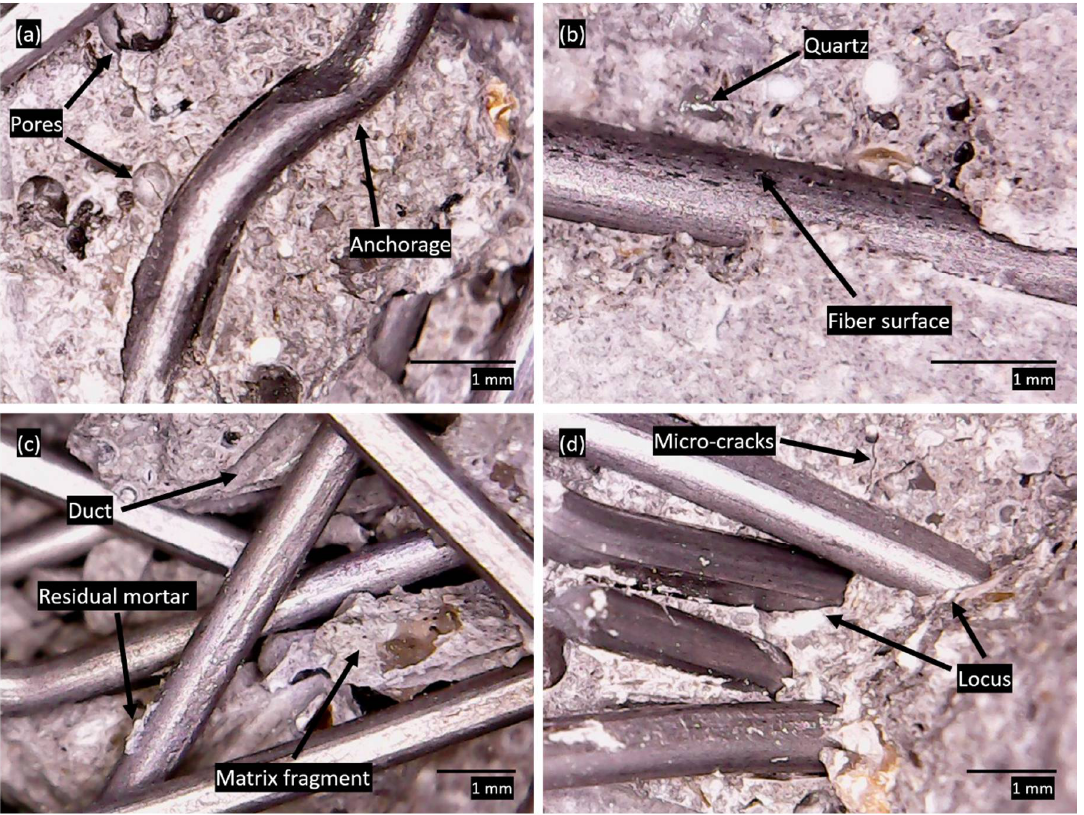
Figure 4. Images obtained by optical microscopy after mechanical testing: ( a ) anchored fibre segment, ( b ) fibre–matrix adhesion in the straight section, ( c ) non-oriented distribution of the fibre in the matrix and ( d ) fibre–matrix bond niche.